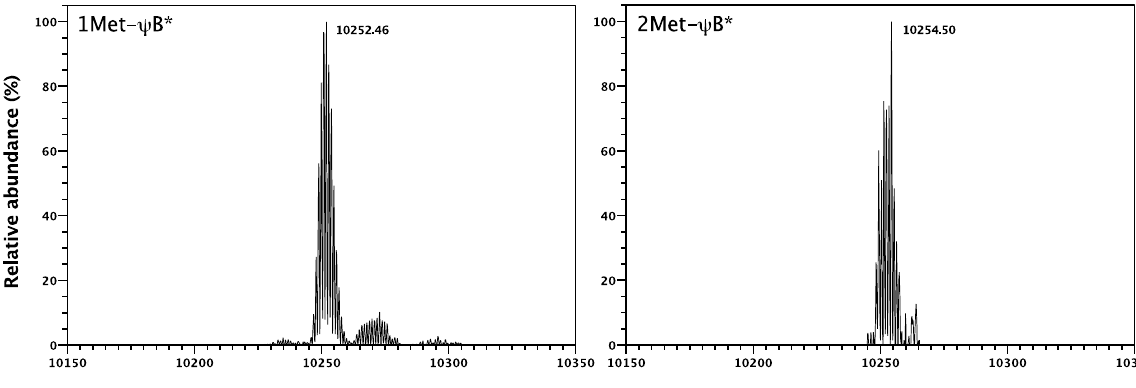
Figure 5. Deconvoluted ESI-MS spectra of 1Met- ψ B*, 1Aha- ψ B*, 2Met- ψ B* and 2Aha- ψ B* forms. The predicted molecular weights of are: 10,252.92, 10,254.99, 10,247.84 Da, and 10,244.83 Da, respectively. The measured molecular weights are shown in the